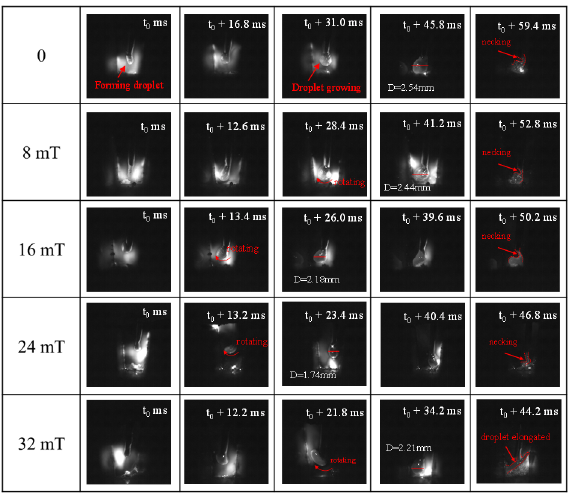
Figure 9. Droplet transfer process at 20 Hz with different magnetic intensity.